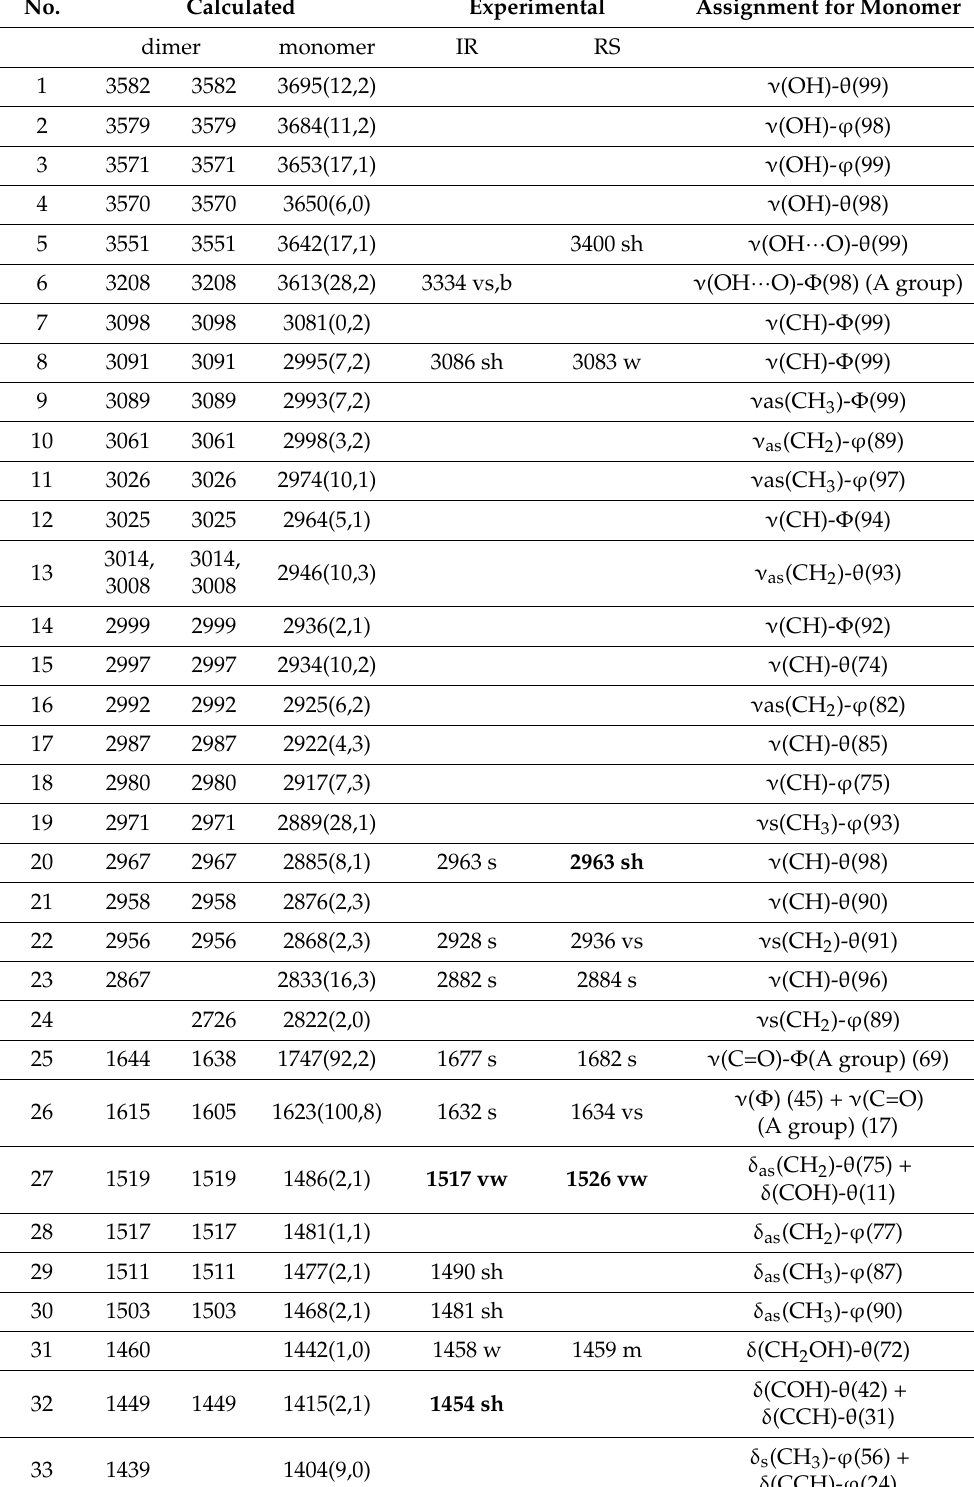
Table 2. Calculated and experimental vibrational wavenumbers with assignments for loganic acid vi- brations. No. Calculated Experimental Assignment for